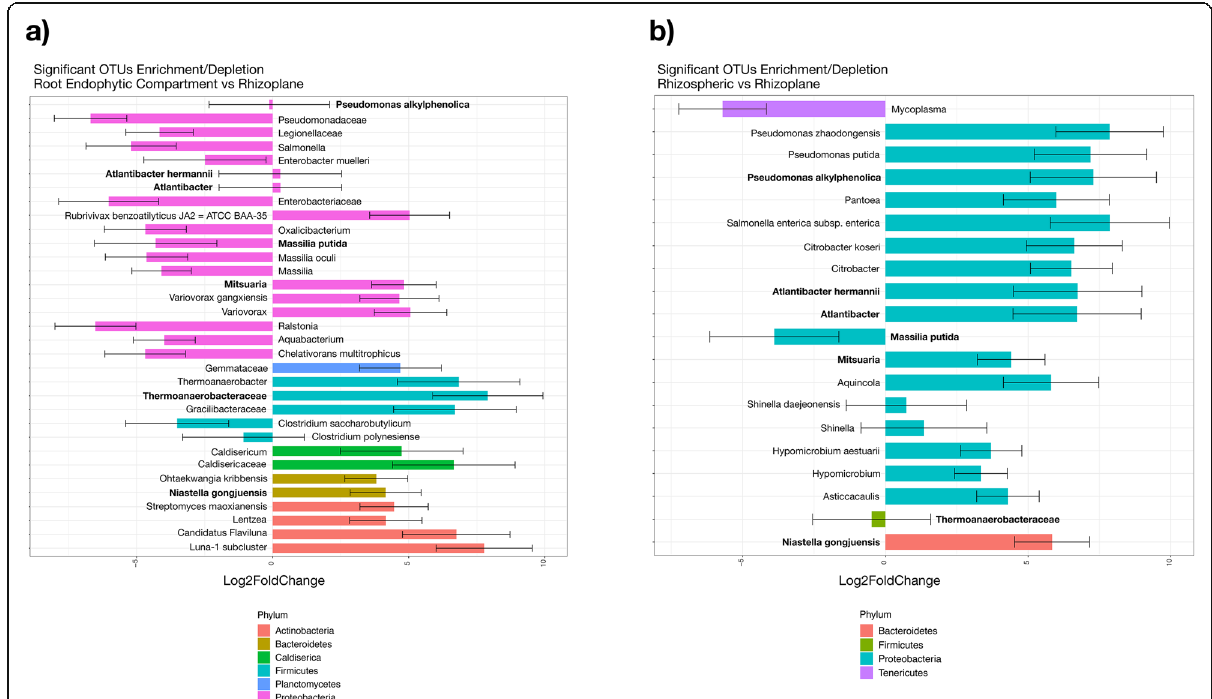
Fig. 7 Comparisons of differentially abundant OTUs. Differentially abundant OTUs (DAOTUs) were evaluated from C. annuum and S. lycopersicum for the a root endophytic compartment and b